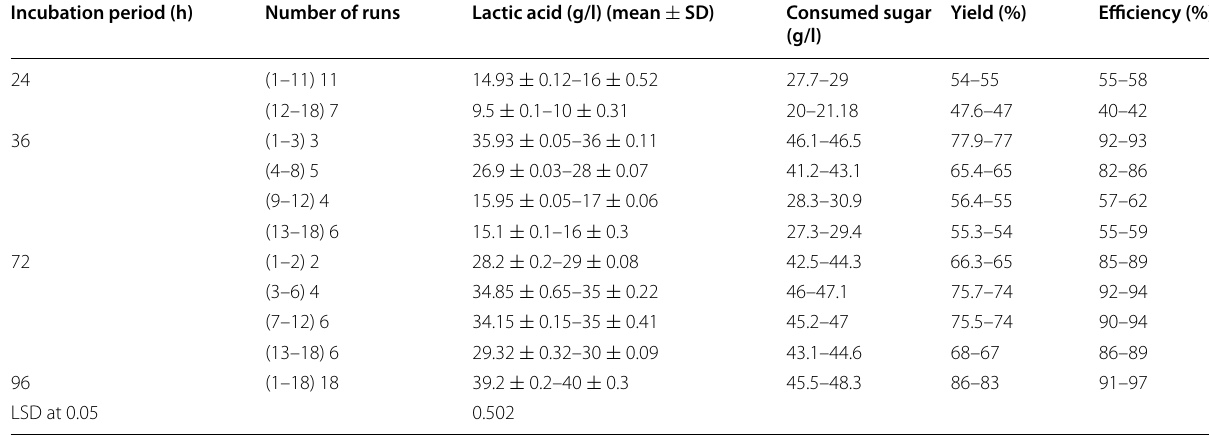
Substrate: salted cheese whey and whey permeate mixture (1:1) with CaCO 3 (0.5%), inoculum size